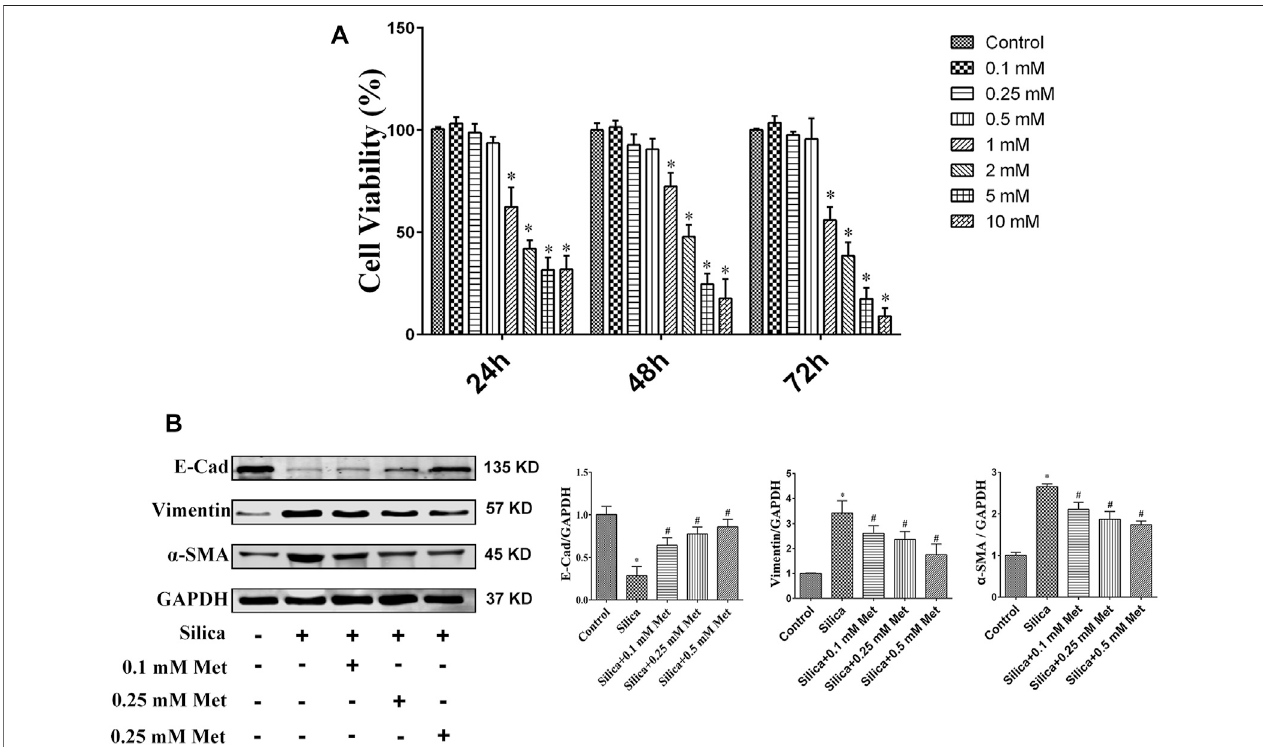
FIGURE 5 | Different concentrations of metformin affect cell viability and inhibit EMT process. (A) The viability of HBEC incubated with different concentrations of metformin was detected by the CCK-8 assay. (B) Western blotting results for the expressions level of EMT-associated proteins on HBEC after co-culture with different concentrations of metformin. All the data are presented as mean ± SD ( n (cid:2) 3 for each experimental group). * p < 0.05, compared to the control group; # p < 0.05, compared to silica group. EMT, epithelial-mesenchymal transition; E-cad, E-Cadherin; α -SMA, α -Smooth muscle actin; Met, metformin.